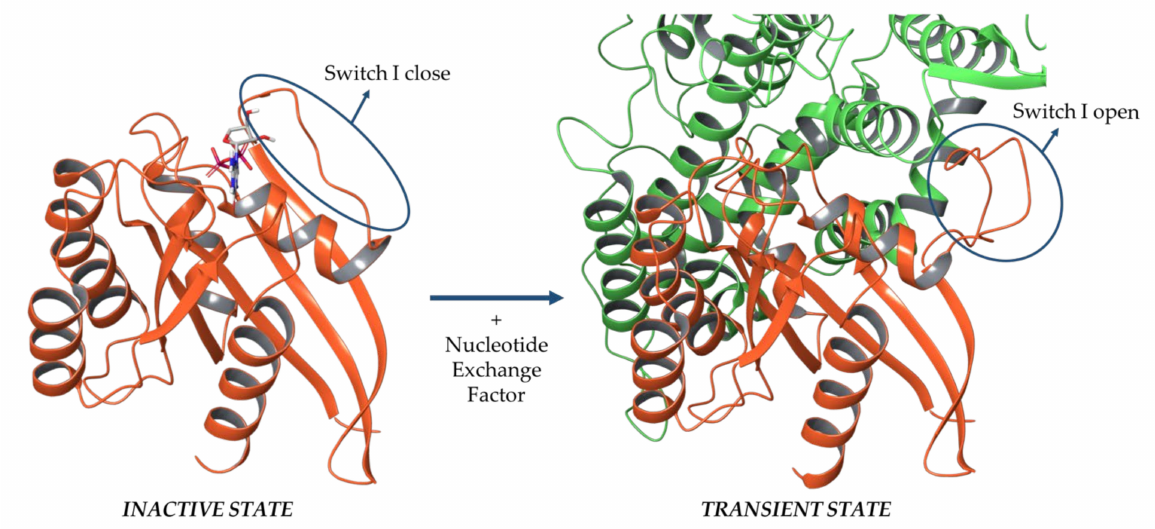
Figure 1. Inactive and transient states of the Ras protein. On the left, a Ras protein (orange chain; PDB ID: 1XD2 [48]) bound to GDP (grey ligand in stick format) exhibits its inactive state, where the Switch I region (highlighted by a blue circle) is closed; on the right, after binding to a guanine nucleotide-exchange factor (Sos protein, green chain), Ras (orange chain; PDB ID: 1XD2) exhibits a transient state, where the Switch I region is open to accommodate the GEF α